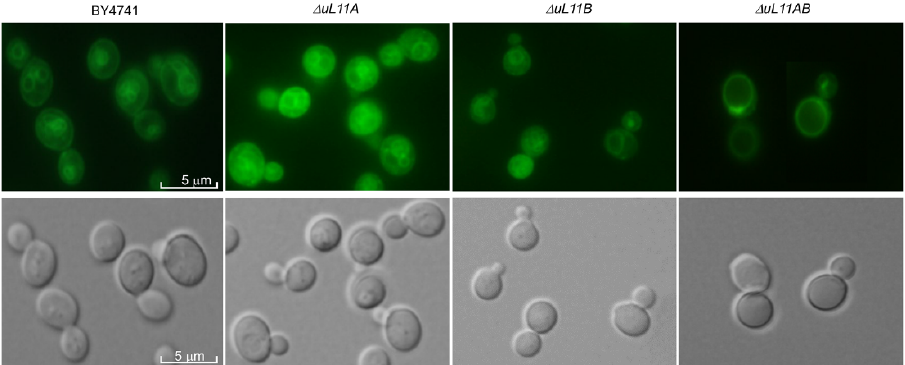
Figure 7. Vacuole morphology analysis. Cells were grown on YPD to an early log phase and stained using a vacuolar marker. Fluorescence pictures were taken with an Olympus BX-51 microscope equipped with a DP-72 digital camera and cellSens Dimension software. Representative results from two independent experiments are shown (1000× magnification).